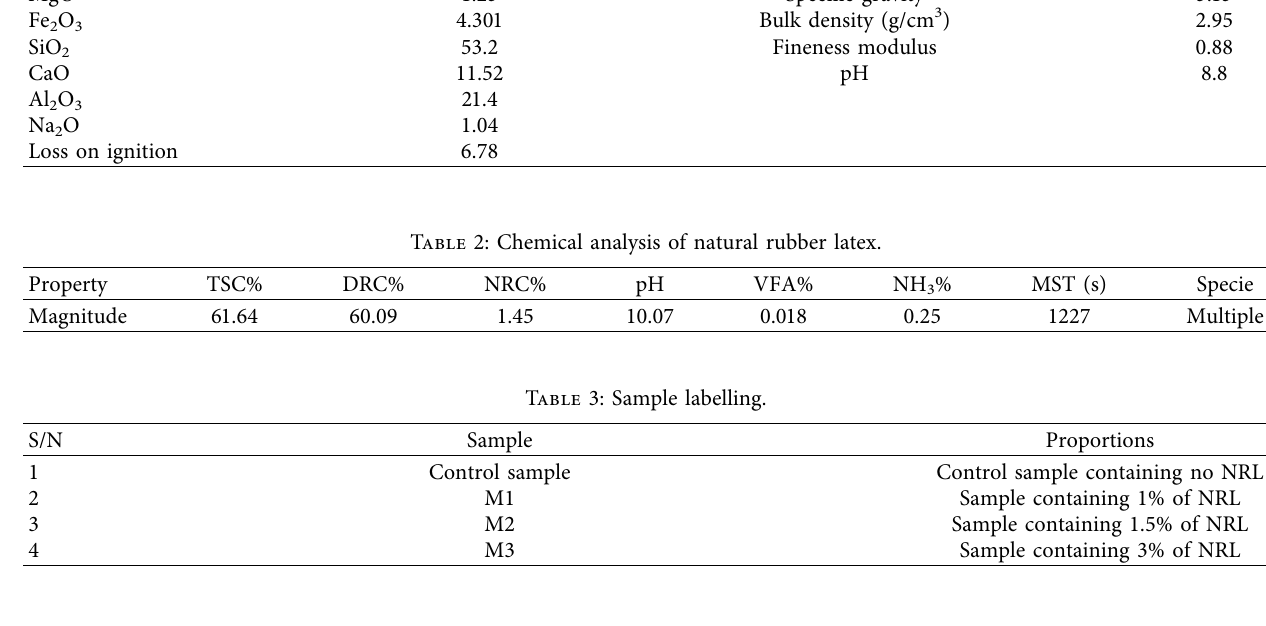
Table 4: Concrete mix